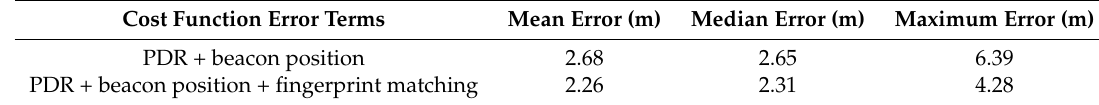
Table 3. Some of the statistics of the beacon position errors for sparse beacons